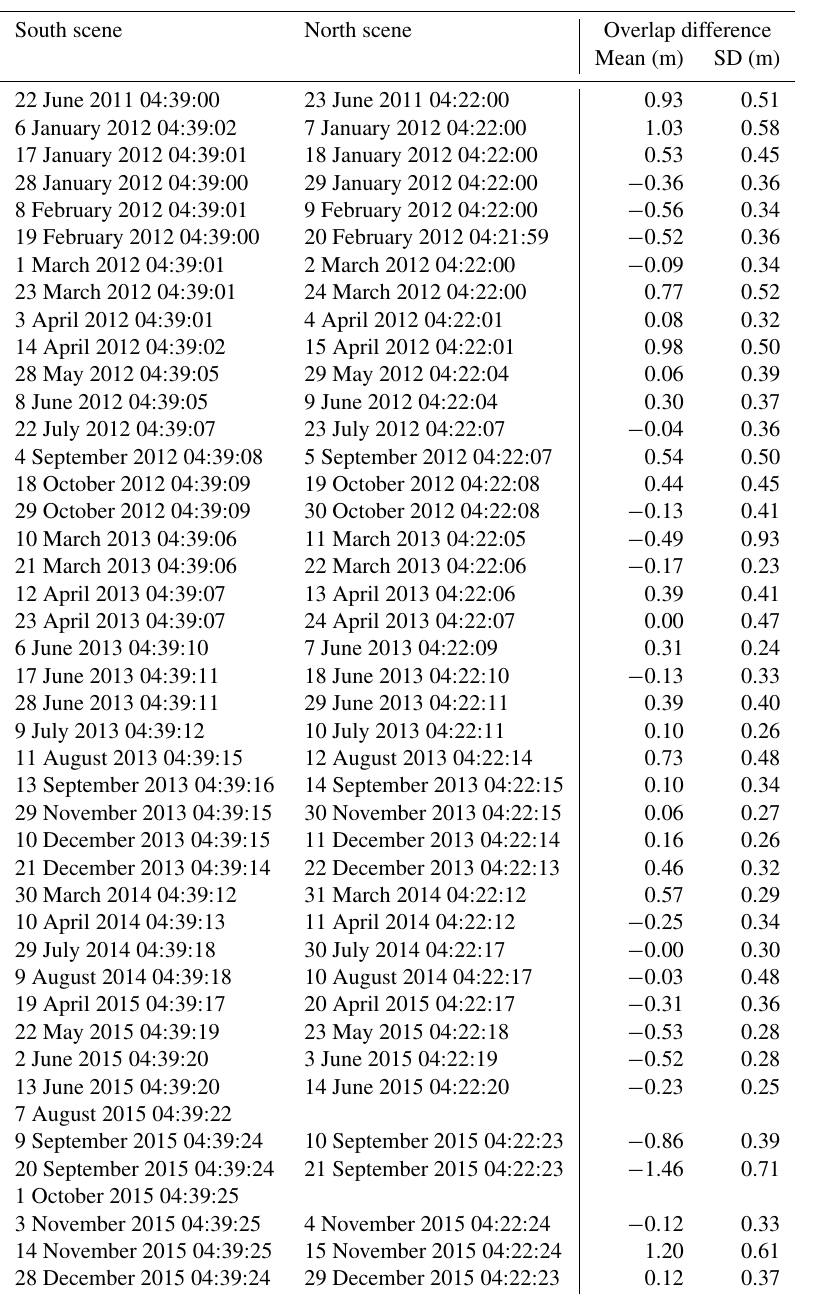
Table A1. TanDEM-X DEM dates and times (UTC). Dates in bold have ICESat-2 points acquired within ± 3d. The overlap elevation differences are based on a 4 × 4km (500 × 500 pixel) patch centred at (75.43 ◦ S, 106.31 ◦ W), over grounded